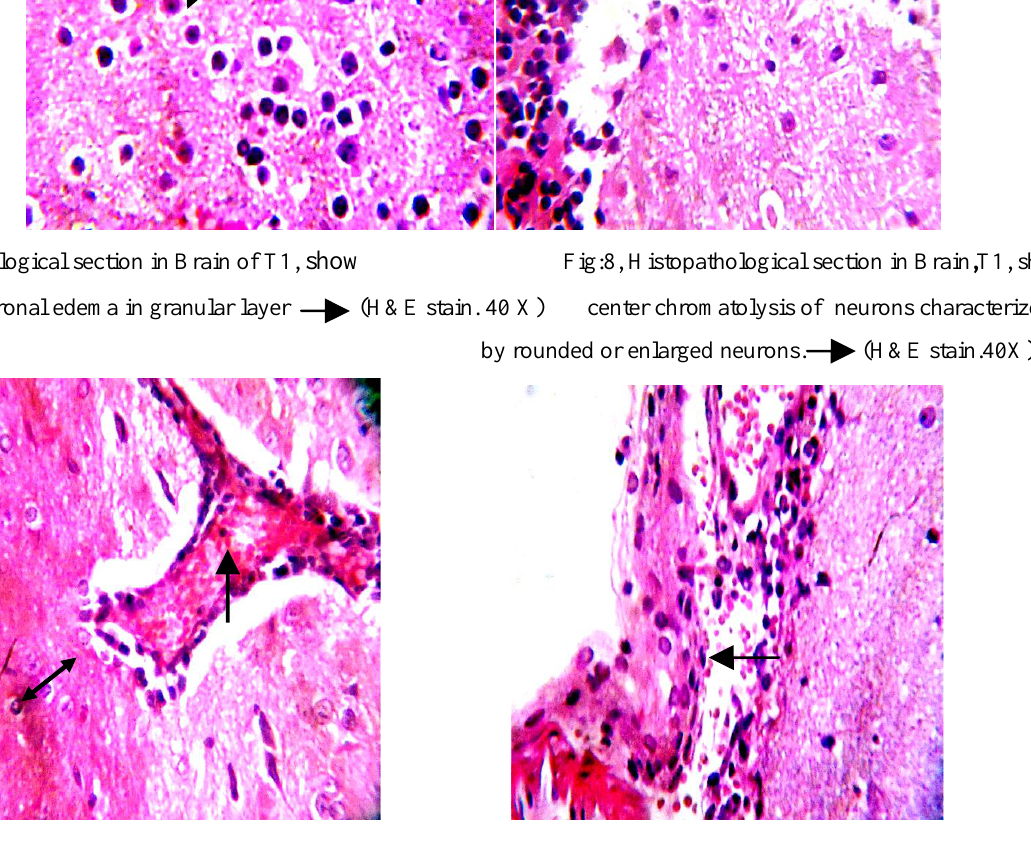
Fig:9, Histopathological section in Brain , T1, show Fig:10, Histopathological section in Brain , T1, show cerebral vascular prominent duct and severe congestion of B.V with inflammatory cells mononuclear cells aggregation around B.Vs in the lumen (H&E stain. 40 X) (H&Estain. 40 343